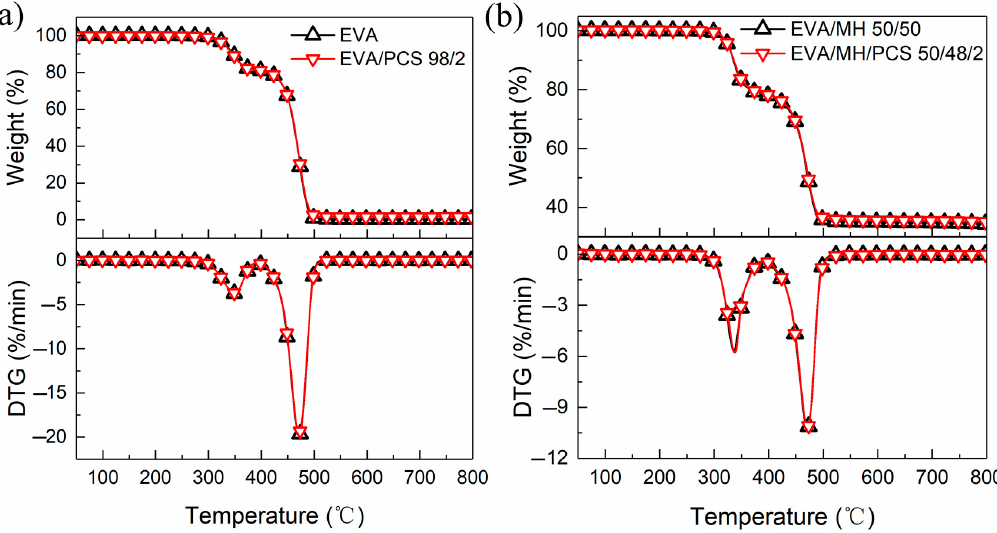
Figure 5. The TG and DTG curves of EVA and its composites: ( a ) EVA and EVA/PCS; ( b ) EVA/MH and EVA/MH/PCS.